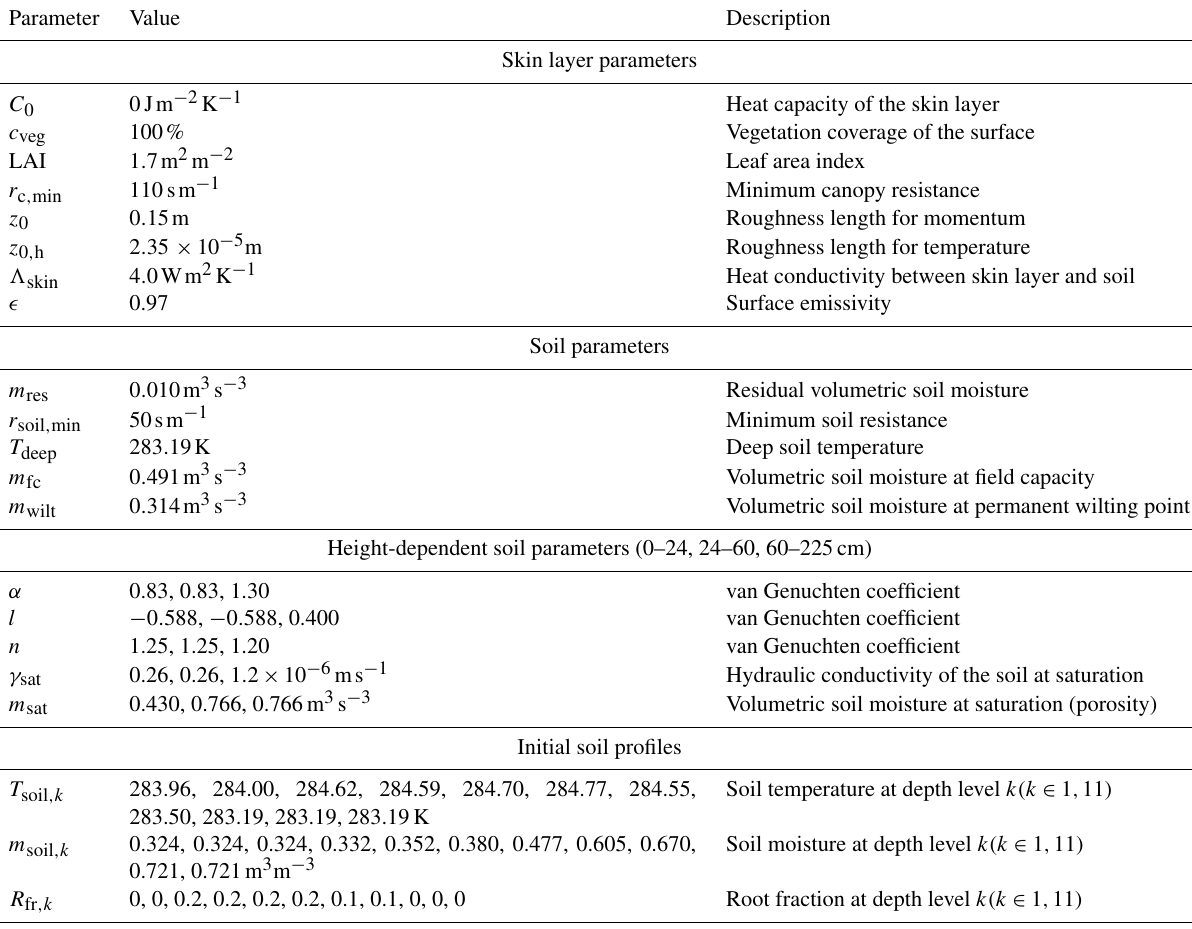
Table 4. Overview of the land surface scheme configuration for case